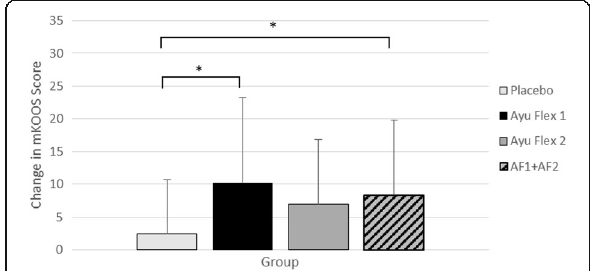
Fig. 4 Mean ± SD changes from Day 0 in mKOOS scores over the course of the study (i.e. higher delta scores indicate greater improvement). Compared to the placebo group, both AF1 ( p = 0.011) and AF1 + AF2 ( p = 0.023) noted greater improvements